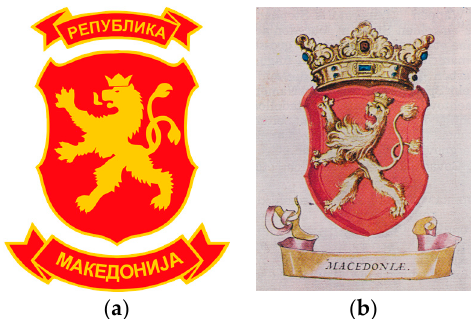
Figure 12. ( a ) Proposal by VMRO-Vistinska; ( b ) Land arm of Macedonia from Belgrade Armorial of 1620.